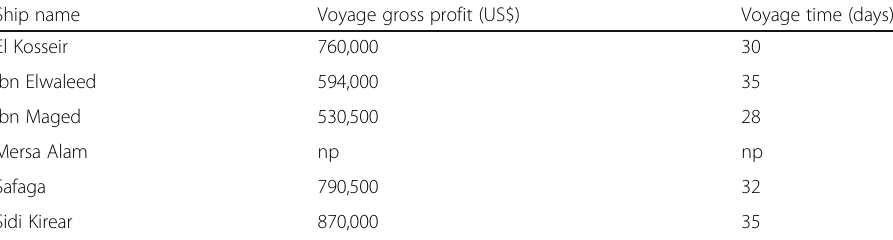
Table 15 Improved voyage gross profit and time in Arabian-Gulf-US trade area, classified by ship Ship